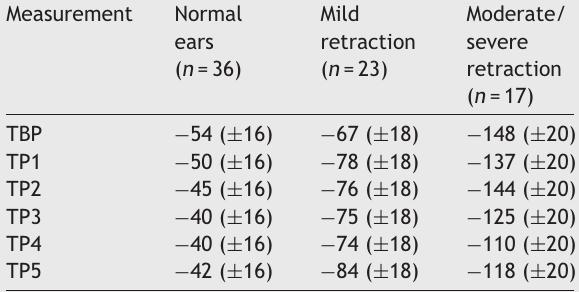
Estimated means obtained with a linear mixed model for the Toynbee maneuver in the three study groups, at the second time point of